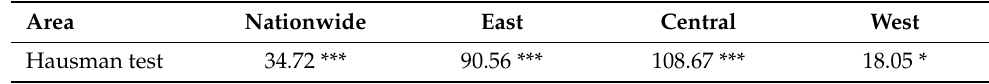
Table 5. Hausman test results.